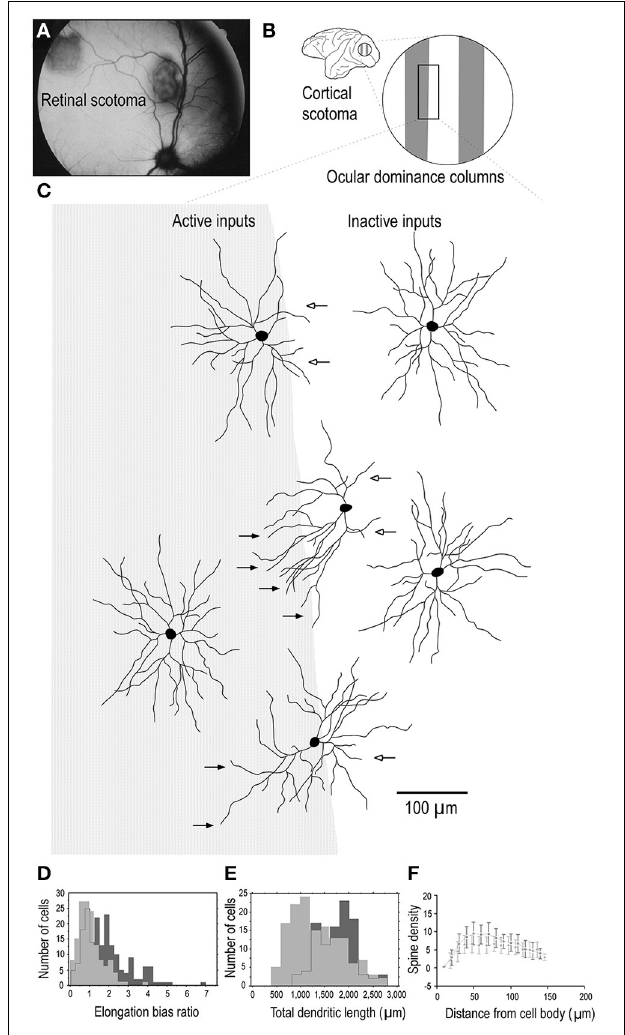
FIGURE 8 | Adult dendritic growth. Schematic illustrating placement of a retinal scotoma (laser lesion) (A) in the adult macaque monkey, and the corresponding region of the contralateral V1 (B) , in which individual neurons were injected across occular dominance columns (C) . Cells located near a border of an ocular dominance column appeared to show a regression of dendrites which projected toward the center of the CO-poor column (open arrows) and an elongation of dendrites toward the CO-rich column (closed arrows). Cells located in the centers of the OD columns appeared to be relatively symmetrical. Comparison of over 400 layer III pyramidal cells intracellularly injected in 3 adult monkeys in which we placed monocular retinal lesions, and 5 age/gender/ hemisphere/layer-matched controls, revealed that the basal dendritic trees of layer III pyramidal neurons within the portion of V1 corresponding to the retinal lesion (the lesion projection zone, LPZ) undergo dendritic growth (D, E) and spinogenesis (F) . Cells in the OD column corresponding to the non-lesioned eye within the LPZ have 65% more spines in their dendritic trees than those in the OD columns corresponding to the lesioned eye. The structural changes are not limited to cells within the LPZ in V1. Neurons in the region of cortex immediately surrounding the LPZ in V1 (the peri-LPZ) are considerably larger and more spinous than those within the LPZ. These cells have double the number of spines in their dendritic trees as compared with those in age/gender/hemisphere/layer-matched controls. Others have also reported perturbations in the peri-LPZ in V1, including marked